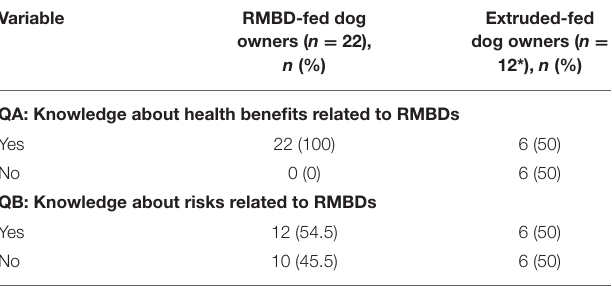
TABLE 3 | Answers to questions to evaluate owners’ knowledge about benefits (QA) and risks (QB) related to RMBDs.